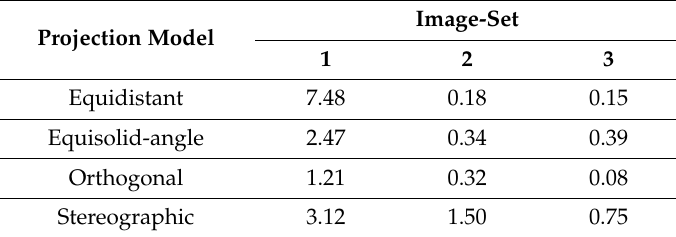
Table 22. RMS-residuals of lens distortion (pixel).